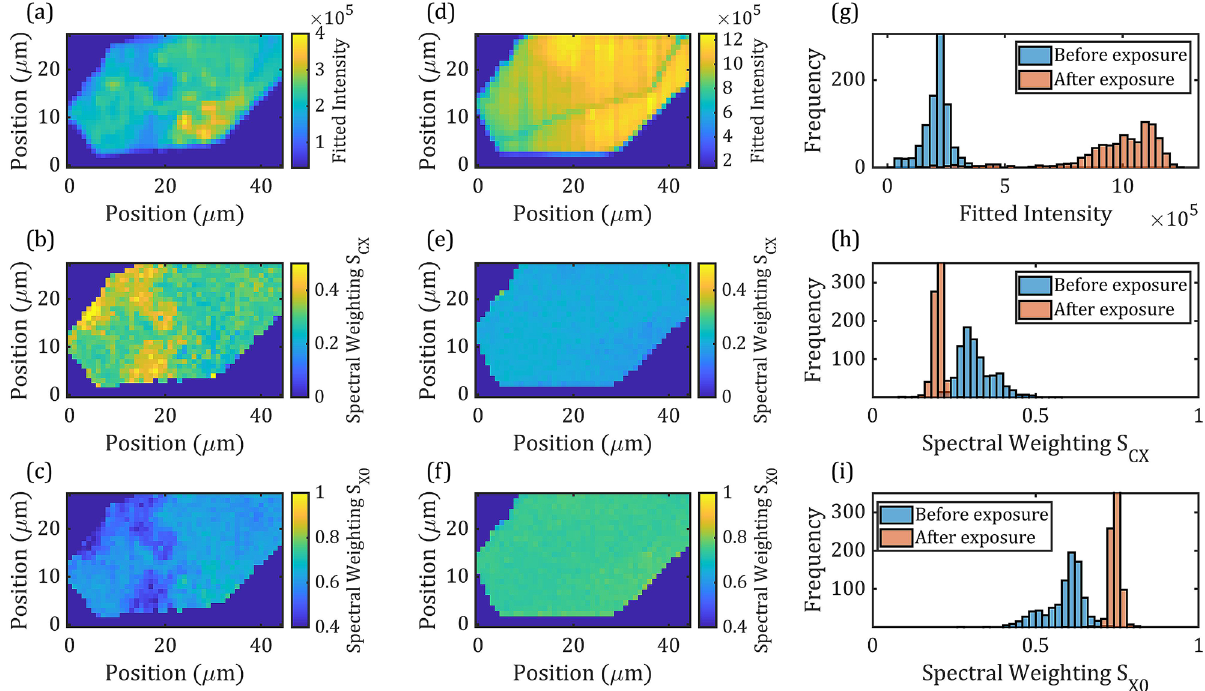
Figure 5. Maps and statistics from large area WS 2 flake illuminated with high power ( I L = 78 kWcm − 2 , 10 s) laser in raster-scan. PL maps are acquired before ( a ) and after ( d ) the laser illumination, S CX and S X 0 maps were extracted from modelling the PL maps both before ( b , c ) and after ( e , f ) the laser illumination. Histograms of the PL peak intensity ( g ), charged exciton ( h ) and exciton ( i ) spectral weightings before and after the laser illumination are then plotted.